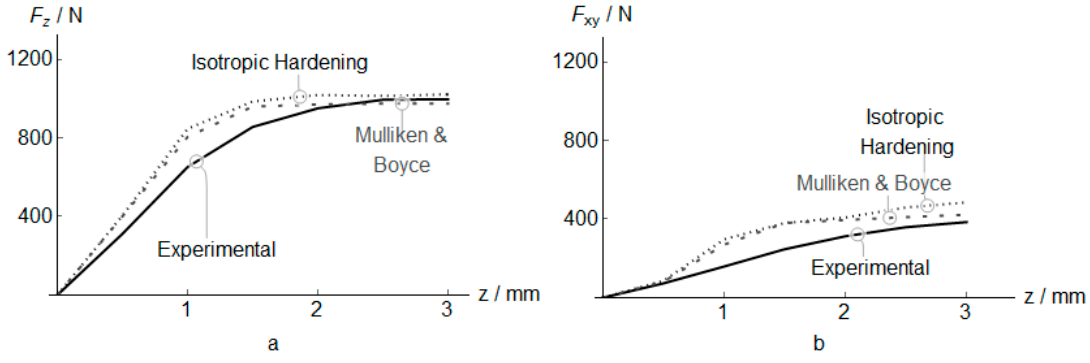
Figure 11. Mulliken and Boyce [20] material vs. the proposed elastoplastic isotropic hardening approach in PVC sheets regarding computational time and maximum F z estimation error.